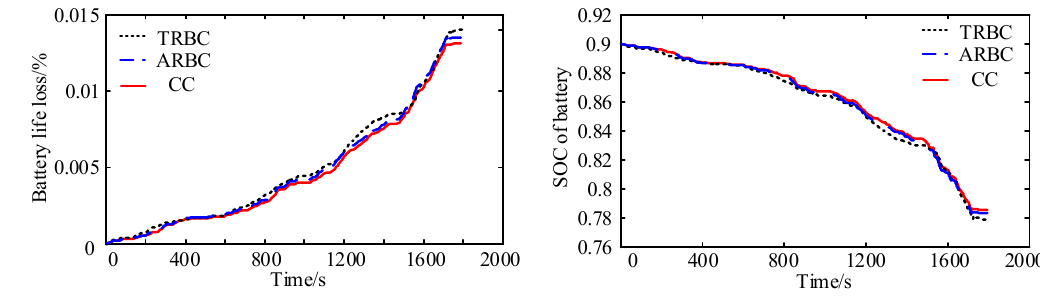
Figure 13. Life loss and SOC of battery.